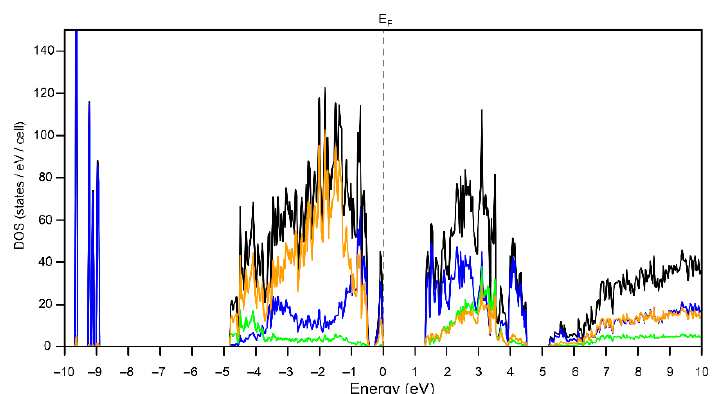
Figure 4. Total (black line) and projected (Bi in Bi 9 5+ -blue line, Bi in [Bi 3 Br 14 5- ]—green line, Br—orange line) DOS near the Fermi level for Bi 6 Br 7 .